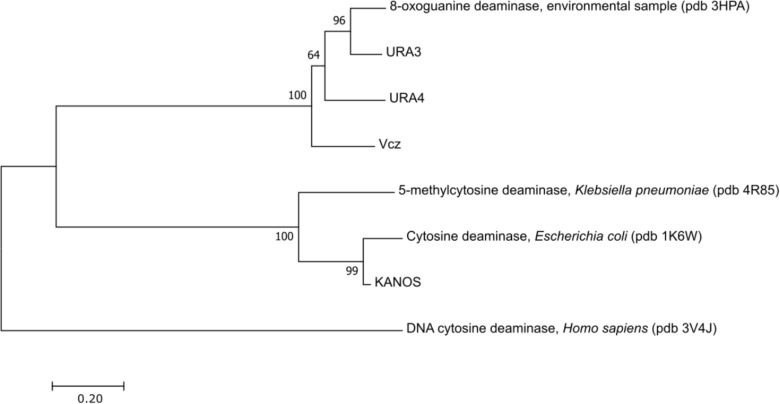
Evolutionary relationships of deaminases. The evolutionary history was inferred using the Neighbor-Joining method (Saitou and Nei, 1987). The optimal tree with the sum of branch length = 3.9 is shown. The percentage of replicate trees in which the associated taxa clustered together in the bootstrap test (1000 replicates) are shown next to the branches (Felsenstein, 1985). The tree is drawn to scale, with branch lengths in the same units as those of the evolutionary distances used to infer the phylogenetic tree. The evolutionary distances were computed using the Poisson correction method (Zuckerkandl and Pauling, 1965) and are in the units of the number of amino acid substitutions per site. The analysis involved 8 amino acid sequences. All positions containing gaps and missing data were eliminated. There were a total of 207 positions in the final dataset. Evolutionary analyses were conducted in MEGA7 (Kumar et al., 2016). This analysis demonstrates that the enzymes found in metagenomic libraries belong to two groups as depicted in the tree: the classical cytosine deaminases (KANOS) and the 8-oxoguanine deaminases (URA3, URA4, and Vcz).